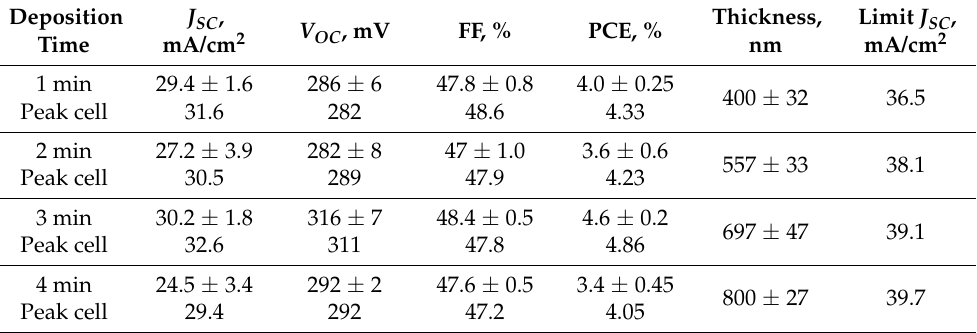
Figure 5. Light ( a ) and dark ( b ) J - V curves of champion Sb 2 Se 3 solar cells fabricated at various deposition times. ( c ) Absorbance spectra of Sb 2 Se 3 solar cells synthesized at different deposition times. ( d ) C - V and 1/C 2 curves measured at 100 kHz frequency under dark conditions of the Sb 2 Se 3 solar cell with an absorber thickness of 490 nm. Table 1. Device performance parameters and absorber thickness of Sb 2 Se 3 solar cells fabricated at different deposition durations. Provided parameters are averages with an error estimated as standard